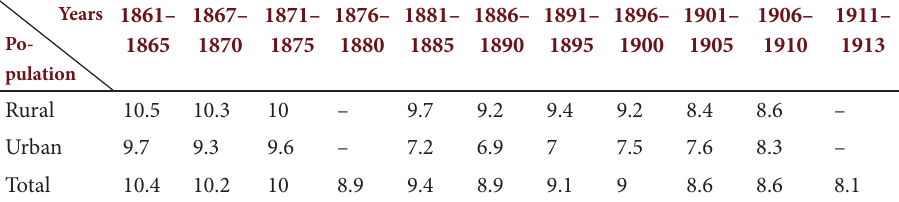
Table 5. Marriage rates in European Russia in 1859-1913, ‰